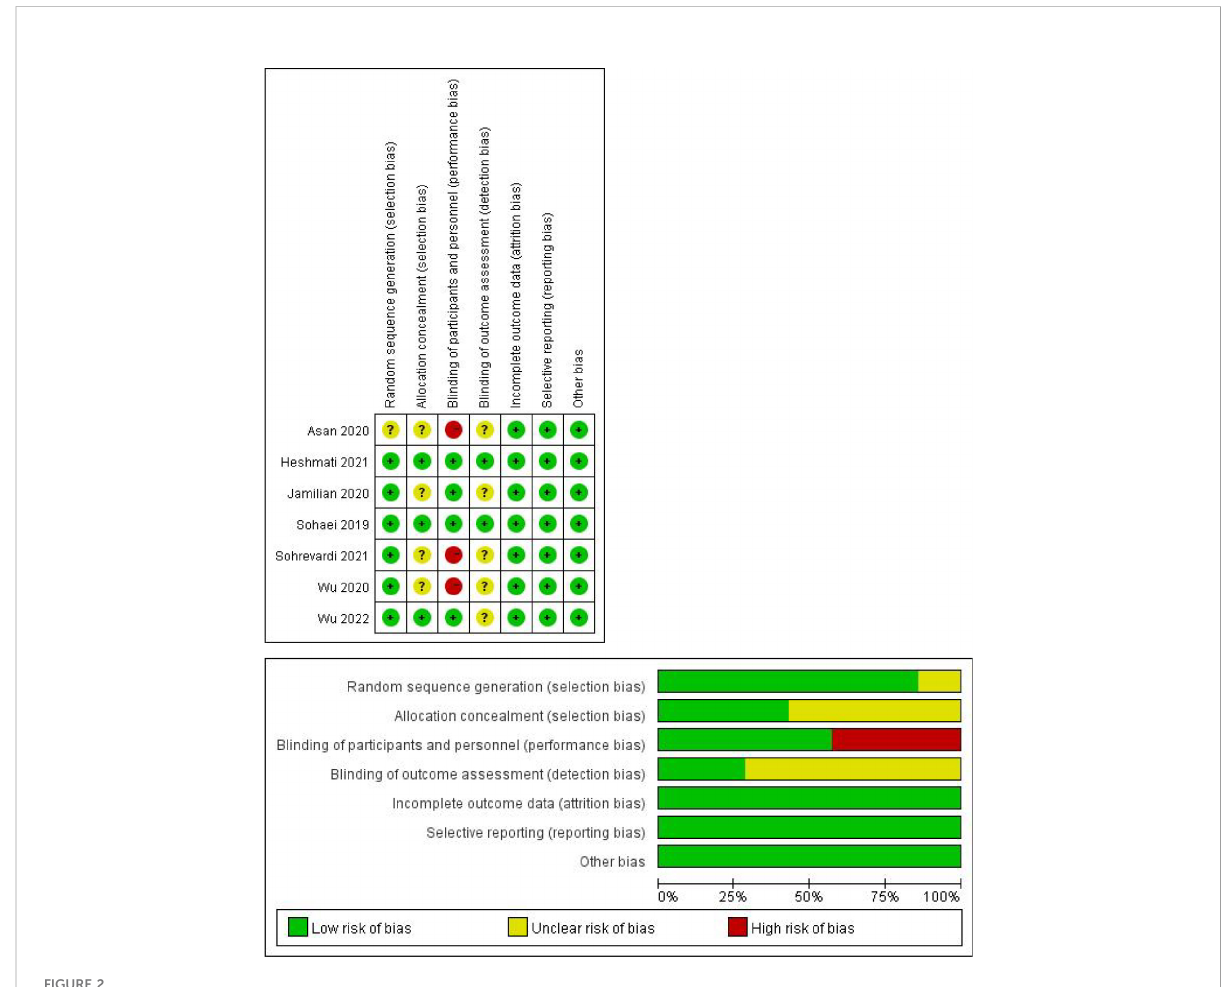
FIGURE 2 Risk of